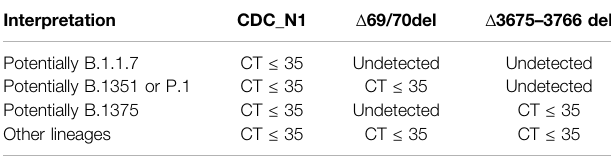
TABLE 1 | Interpretation of results of RT-qPCR assay for SARS-CoV-2